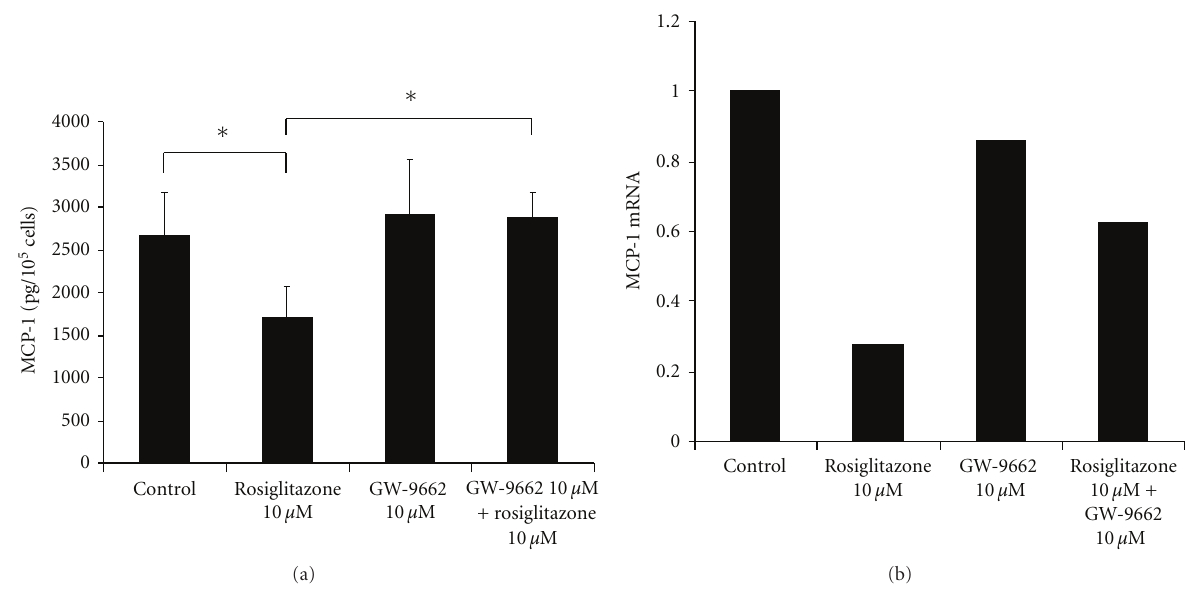
Figure 4: (a) PPAR- γ -dependency of the rosiglitazone e ff ect on mesothelial MCP-1 release. MC were preincubated with GW-9662 10 μ M for 24 hours (or with control media) and then incubated with the given conditions for 8 hours. Cell supernatants were examined by ELISA. ∗ indicates a P value < 0.05 ( n = 5). (b) PPAR- γ -dependency of the rosiglitazone e ff ect on mesothelial MCP-1 mRNA expression. MC were preincubated with GW-9662 10 μ M for 24 hours (or with control media) and then incubated with the given conditions for 8 hours. Total RNA was extracted and examined by RT-PCR. The figure shows a representative experiment out of three independent ones.